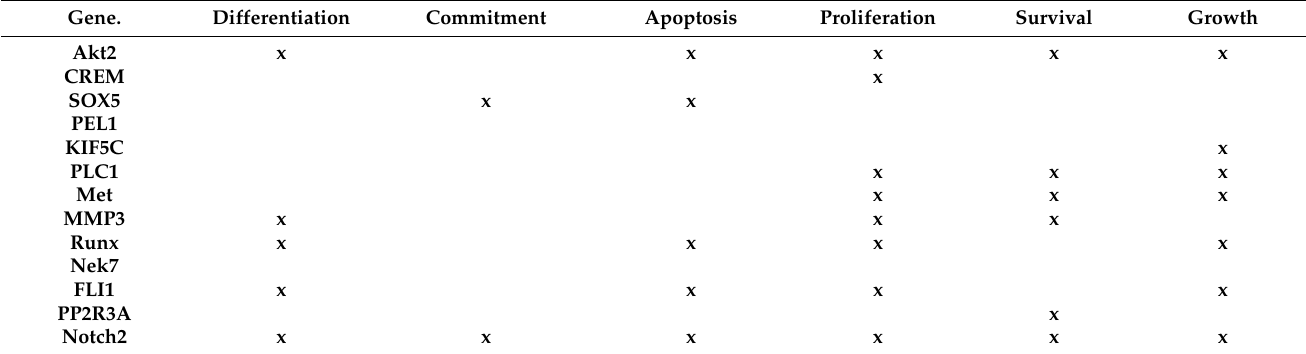
Table 1. Ontological analysis of cloned Mlip mediated chromatin immunoprecipitated DNA fragments. Gene.